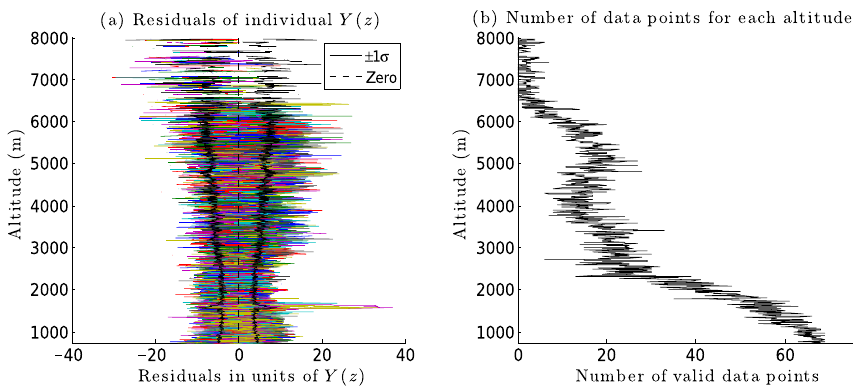
Figure 6. (a) The residuals of individual Y(z) profiles for 10 March 2013 are shown after subtracting the nightly power law fit. Solid black lines indicate ± 1 σ of the measured profiles. The dashed line at zero emphasizes the lack of bias in the fit. (b) The number of valid data points for Y(z) at each altitude. More data points are available anywhere photon signals are high, such as at low altitudes and inside clouds. The deviation of the residuals from zero in the left figure above 6000m is explained by the lack of data points above this